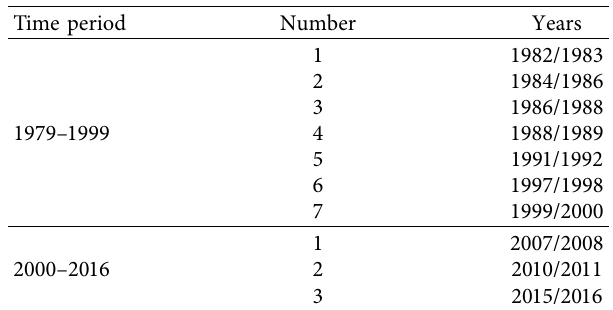
Figure 10: Monthly EP-type ENSO index ( I The blue asterisks denote the time points of selected EP-type ENSO events. Table 1: EP-type ENSO events during 1979–1999 and 2000–2016. Time